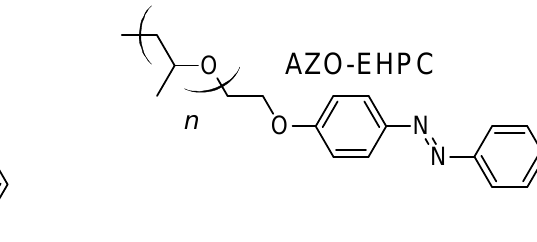
Figure 14. AZO-EHPC or AZO-HPHPC formula.